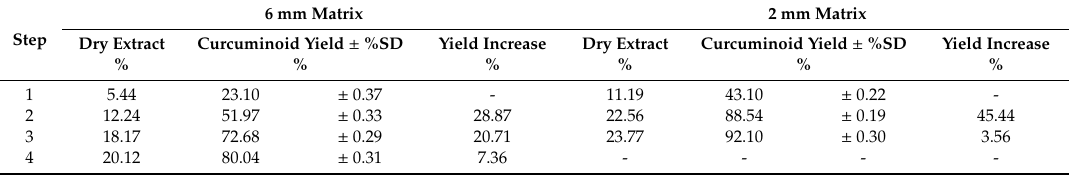
Table 5. Cross-flow UAE, step screening with 6 and 2 mm